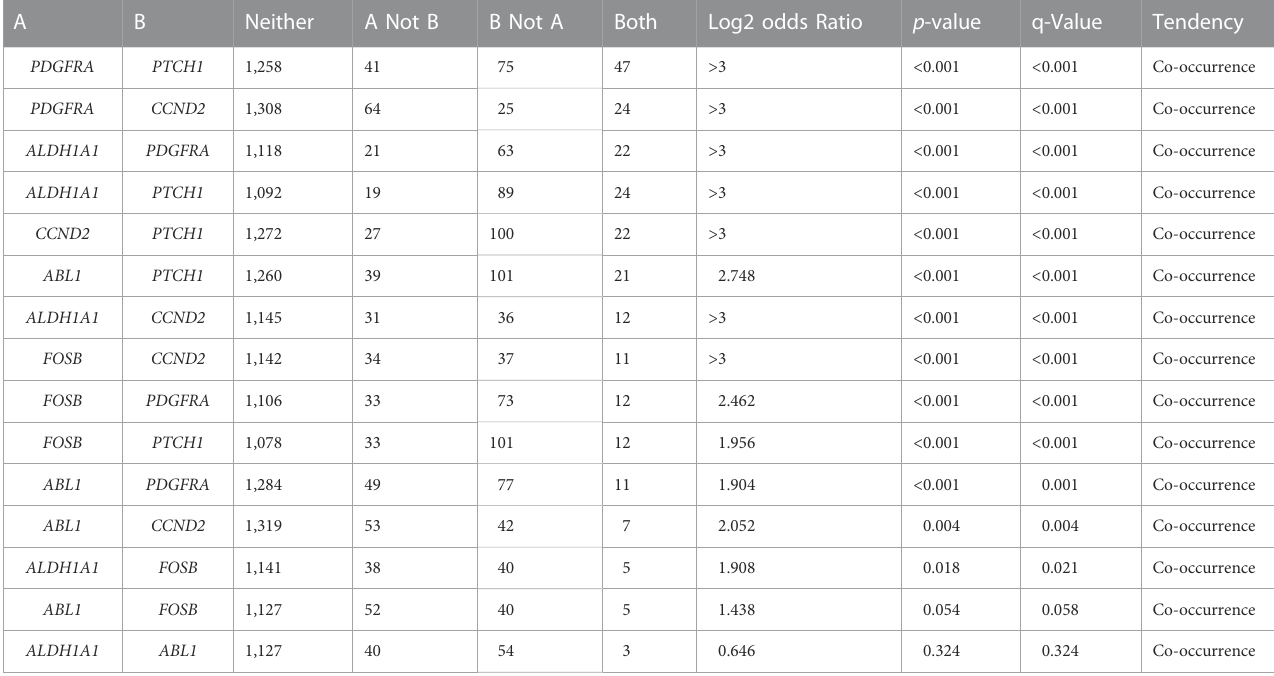
TABLE 5 The co-occurrence of mutations in the hub genes of endometrial